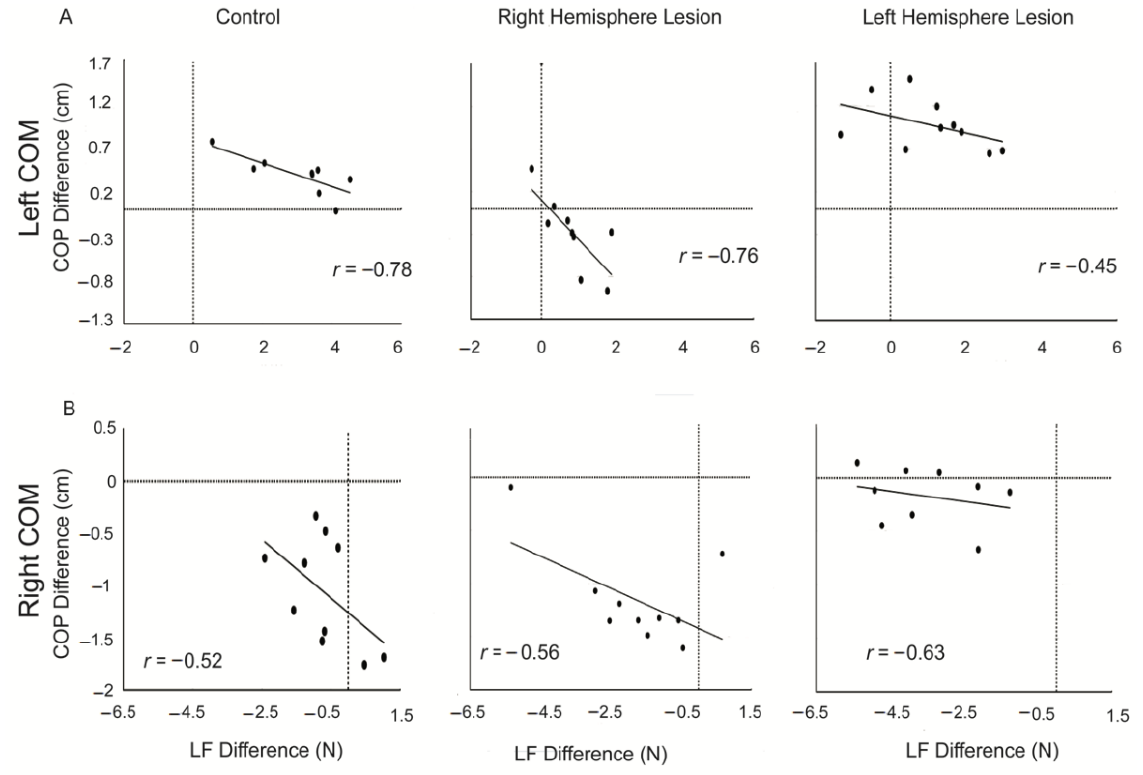
Figure 5. Representative scatter plot of the covariation of load force (LF) difference and center of pressure (COP) difference for each individual trail for a participant from each group for the ( A ) left and ( B ) right center of mass (COM) locations. Pearson’s r correlation coefficient is shown for the 10 experimental trials.